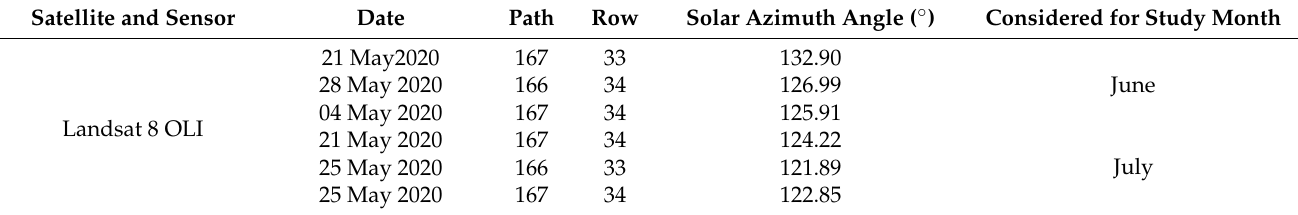
Table 3. Specifications of Landsat 8 satellite images used in the present study.